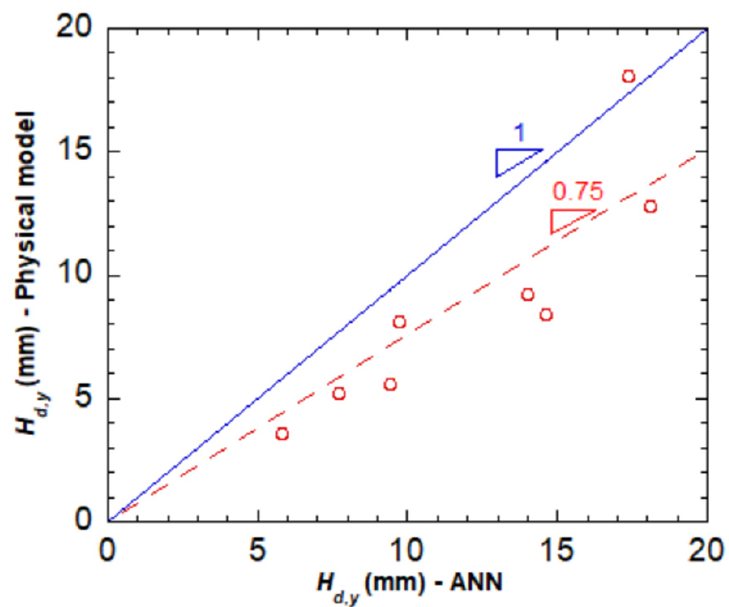
Figure 3. Yearly dew yields (mm·yr − 1 ) for eight cities of Morocco as obtained from the physical model estimation (ordinate, Equation (3)) compared with the data obtained from an artificial neural network approach using the Mirleft data (abscissa, [17]). The full line corresponds to the equality of both calculations.